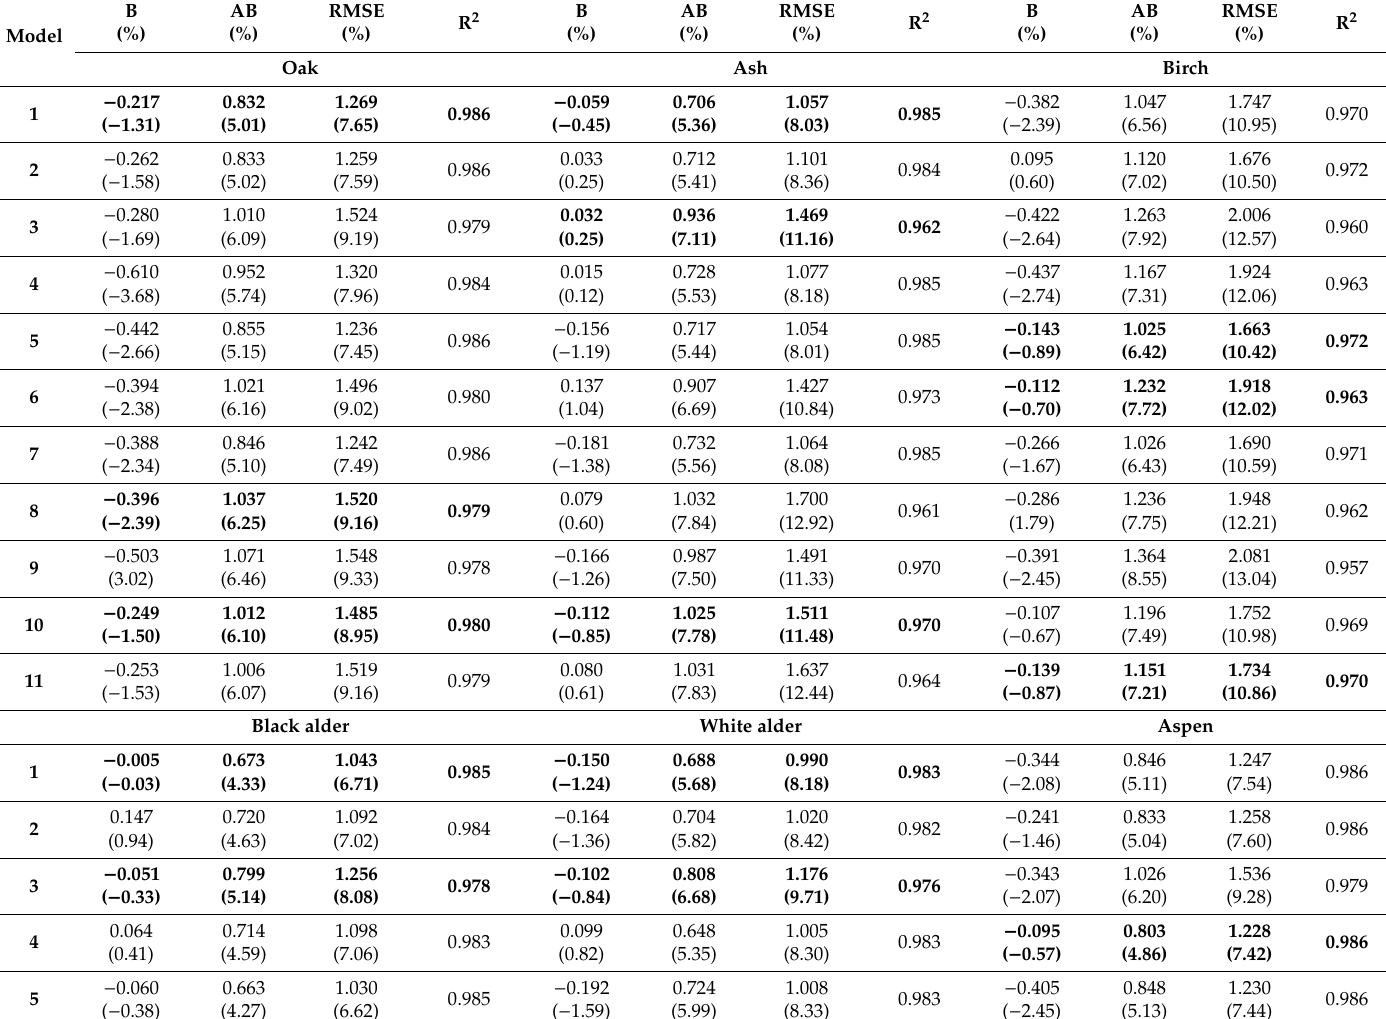
Table 2. Statistical measures for all of the validated stem diameter models